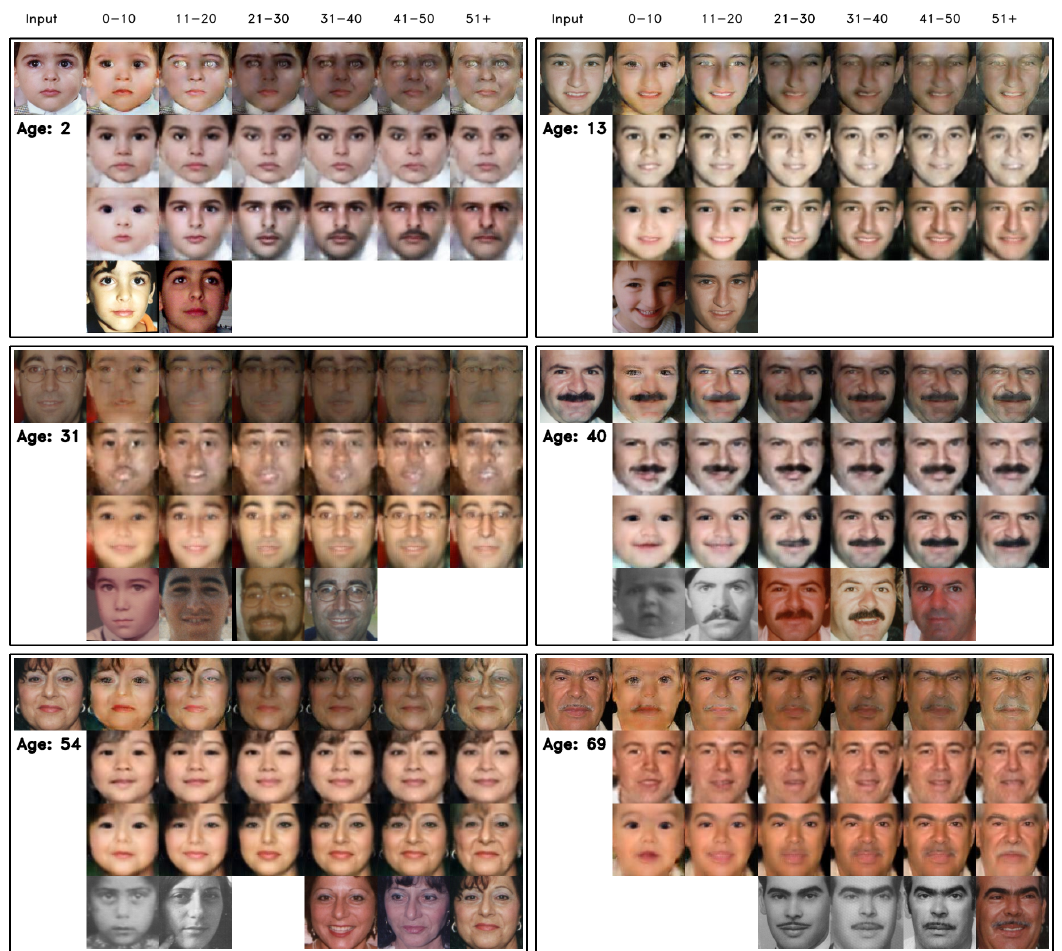
Figure 7. The results with three methods (in each box, from top to bottom: Identity-Preserved Conditional Generative Adversarial Networks (IPCGANs), CAAE, SS-FaceGAN and the real images). For every person, the real images (the top-left image and the images in 4th row) and the synthesized images for 6 age groups are